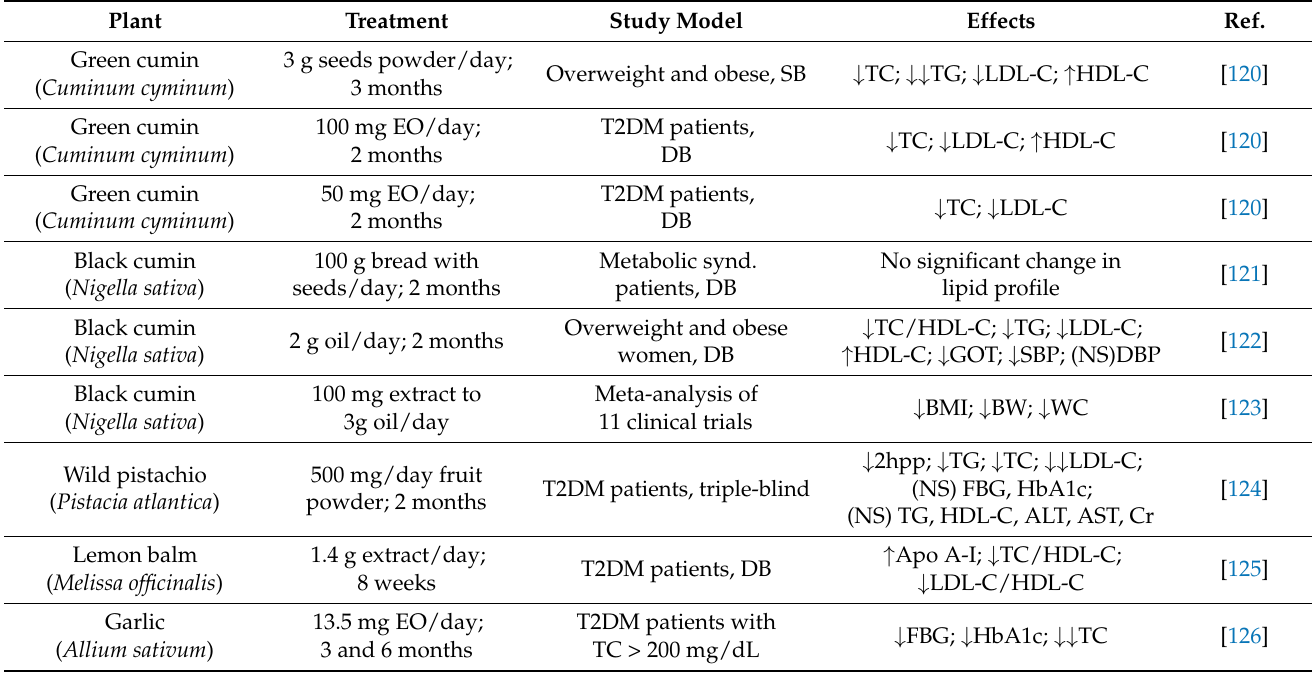
Table 2. Representative clinical trials of essential oils in the treatment of dyslipidemia.